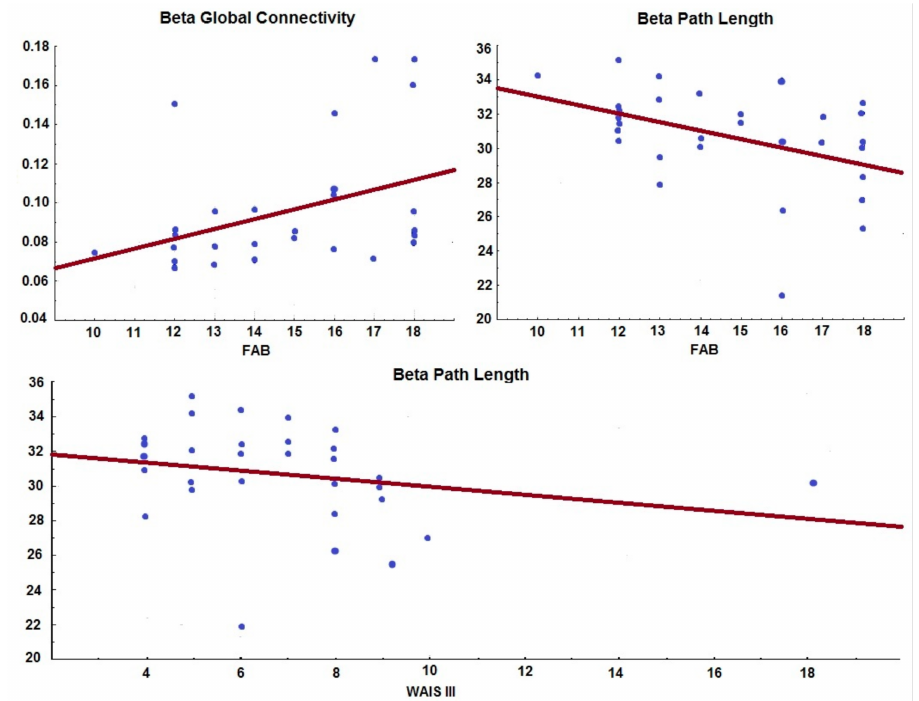
Figure 4. Relationship between the cognitive performance assessed by the FAB (executive functions) and WAIS-III (working memory) scales and the functional integration variables of the network (beta mean path length and beta global connectivity). Spearman correlation ( p <